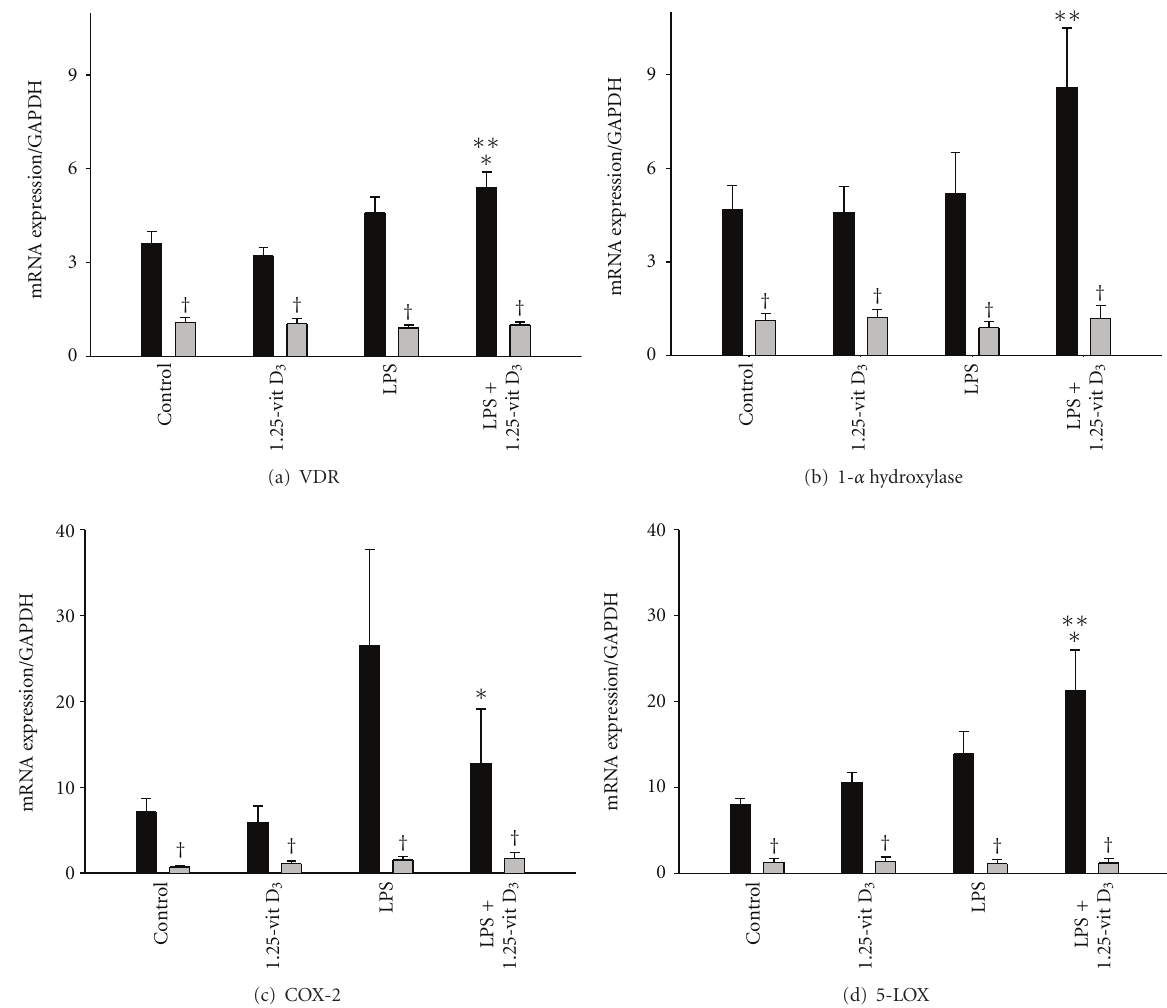
Figure 1: E ff ects of LPS and 1, 25-vit D 3 on expression of VDR, 1- α hydroxylase, COX-2, and 5-LOX in neutrophils. Adult (black column) and neonatal (grey column) neutrophils were incubated with LPS (1 μ g/mL) and/or 1,25-Vit D 3 (10 − 7 M), or medium control for 4h. mRNA expression of the (a) VDR, (b) 1- α hydroxylase, (c) COX-2, and (d) 5-LOX. Results were normalized to GAPDH expression. Each bar represents the mean ± SE ( n = 7–11). ∗ Significantly di ff erent ( P < 0 . 05) from LPS; ∗∗ significantly di ff erent ( P < 0 . 05) from control; † significantly di ff erent ( P < 0 . 05) from adult.